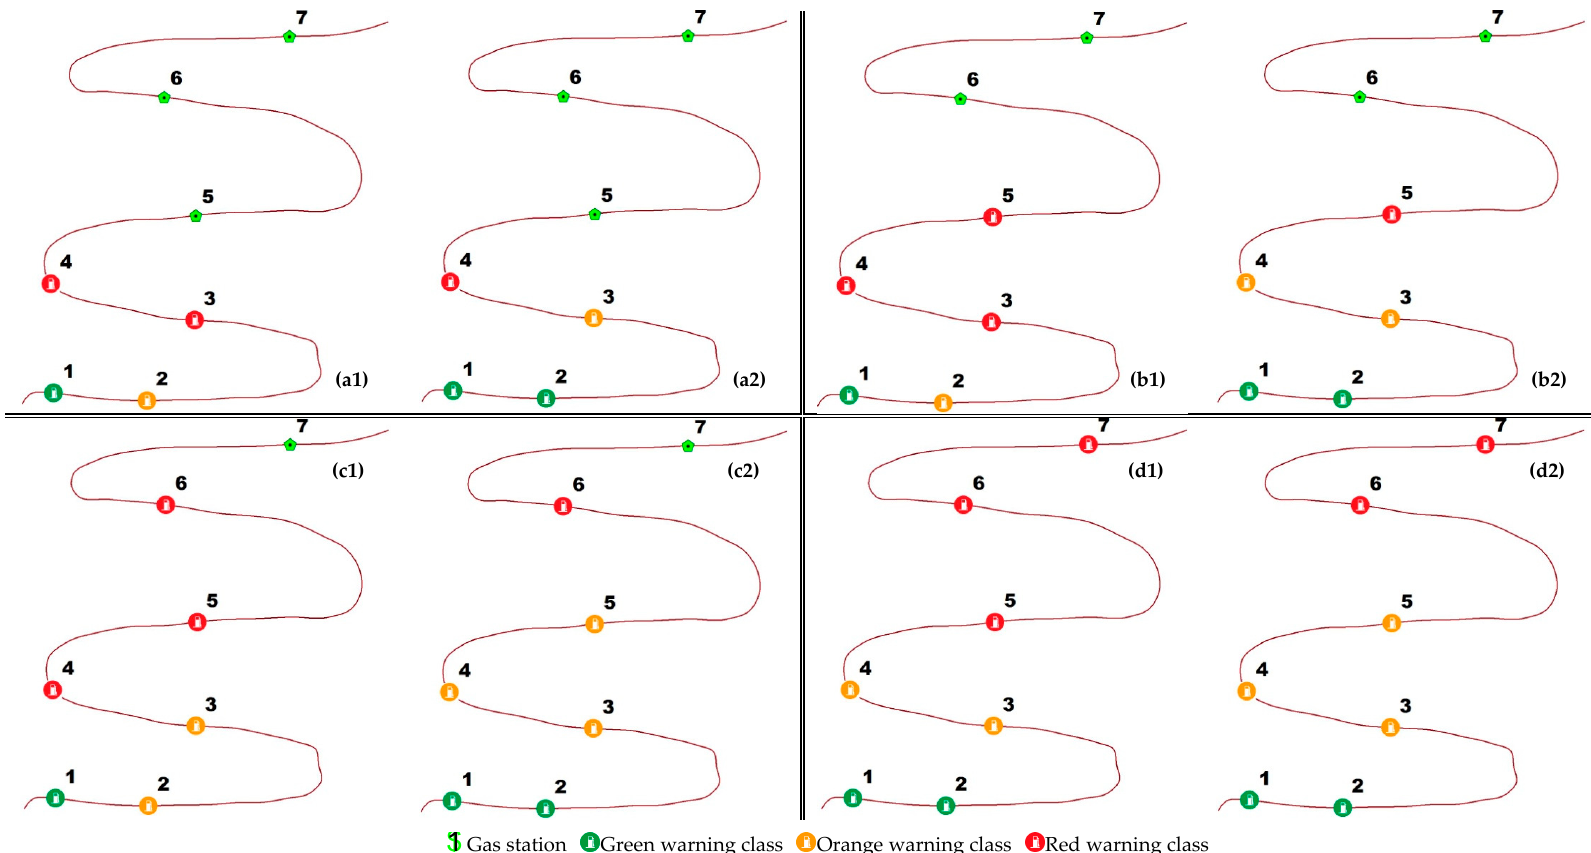
Figure 7. Results comparison between the hierarchical clustering algorithm and the K-Means clustering algorithm. ( a1 , b1 , c1 , and d1 ) show the clustering results of the K-Means algorithm when the number of gas stations is 4, 5, 6, or 7; ( a2 , b2 , c2 , and d2 ) show the clustering results of the hierarchical clustering algorithm when the number of gas stations is 4, 5, 6, or 7.